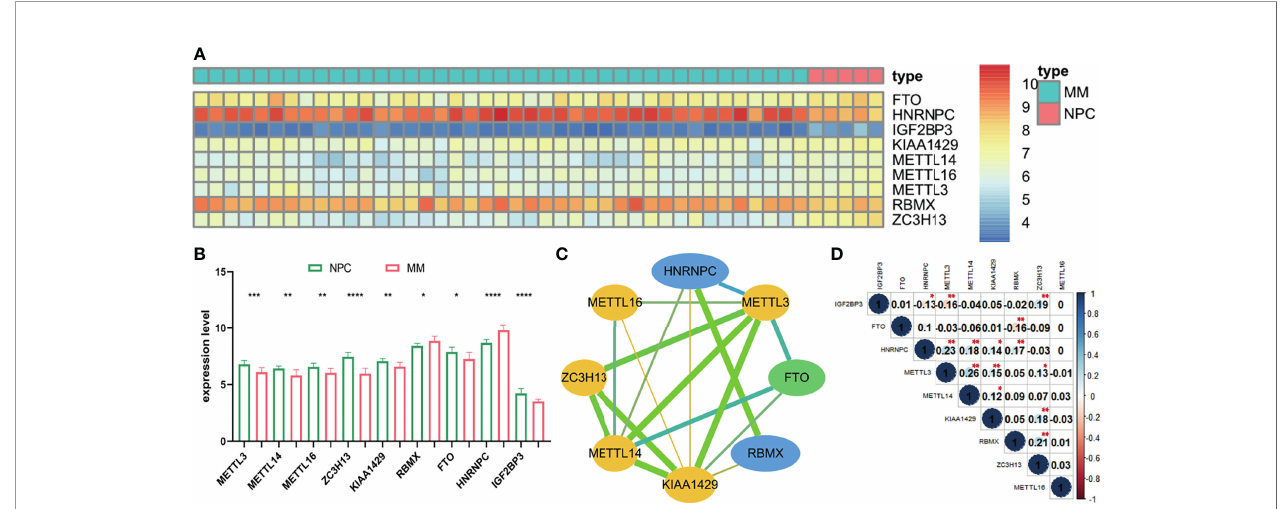
FIGURE 1 | The expression status and correlation of differentially expressed m6A-related genes in MM. The heatmap (A) and the bar chart (B) showed the expression of nine differentially expressed m6A-related regulators in 41 MM and 5 NPC samples from the GSE47552 dataset. The color bar of heatmap from red to blue denotes high to low gene expression. (C) The PPI network of the differentially expressed m6A-related genes. Yellow, green, and blue nodes represent “ writer, ” “ eraser, ” and “ reader, ” respectively. Node size represents the expression value. Edge size represents the combined score (low score to orange and high score to green). (D) The Spearman correlation analysis of the differentially expressed m6A-related genes. The size of each circle denotes the Spearman correlation coef fi cient (negativity to red and positivity to blue). * p < 0.05, ** p < 0.01, *** p < 0.001, **** p <